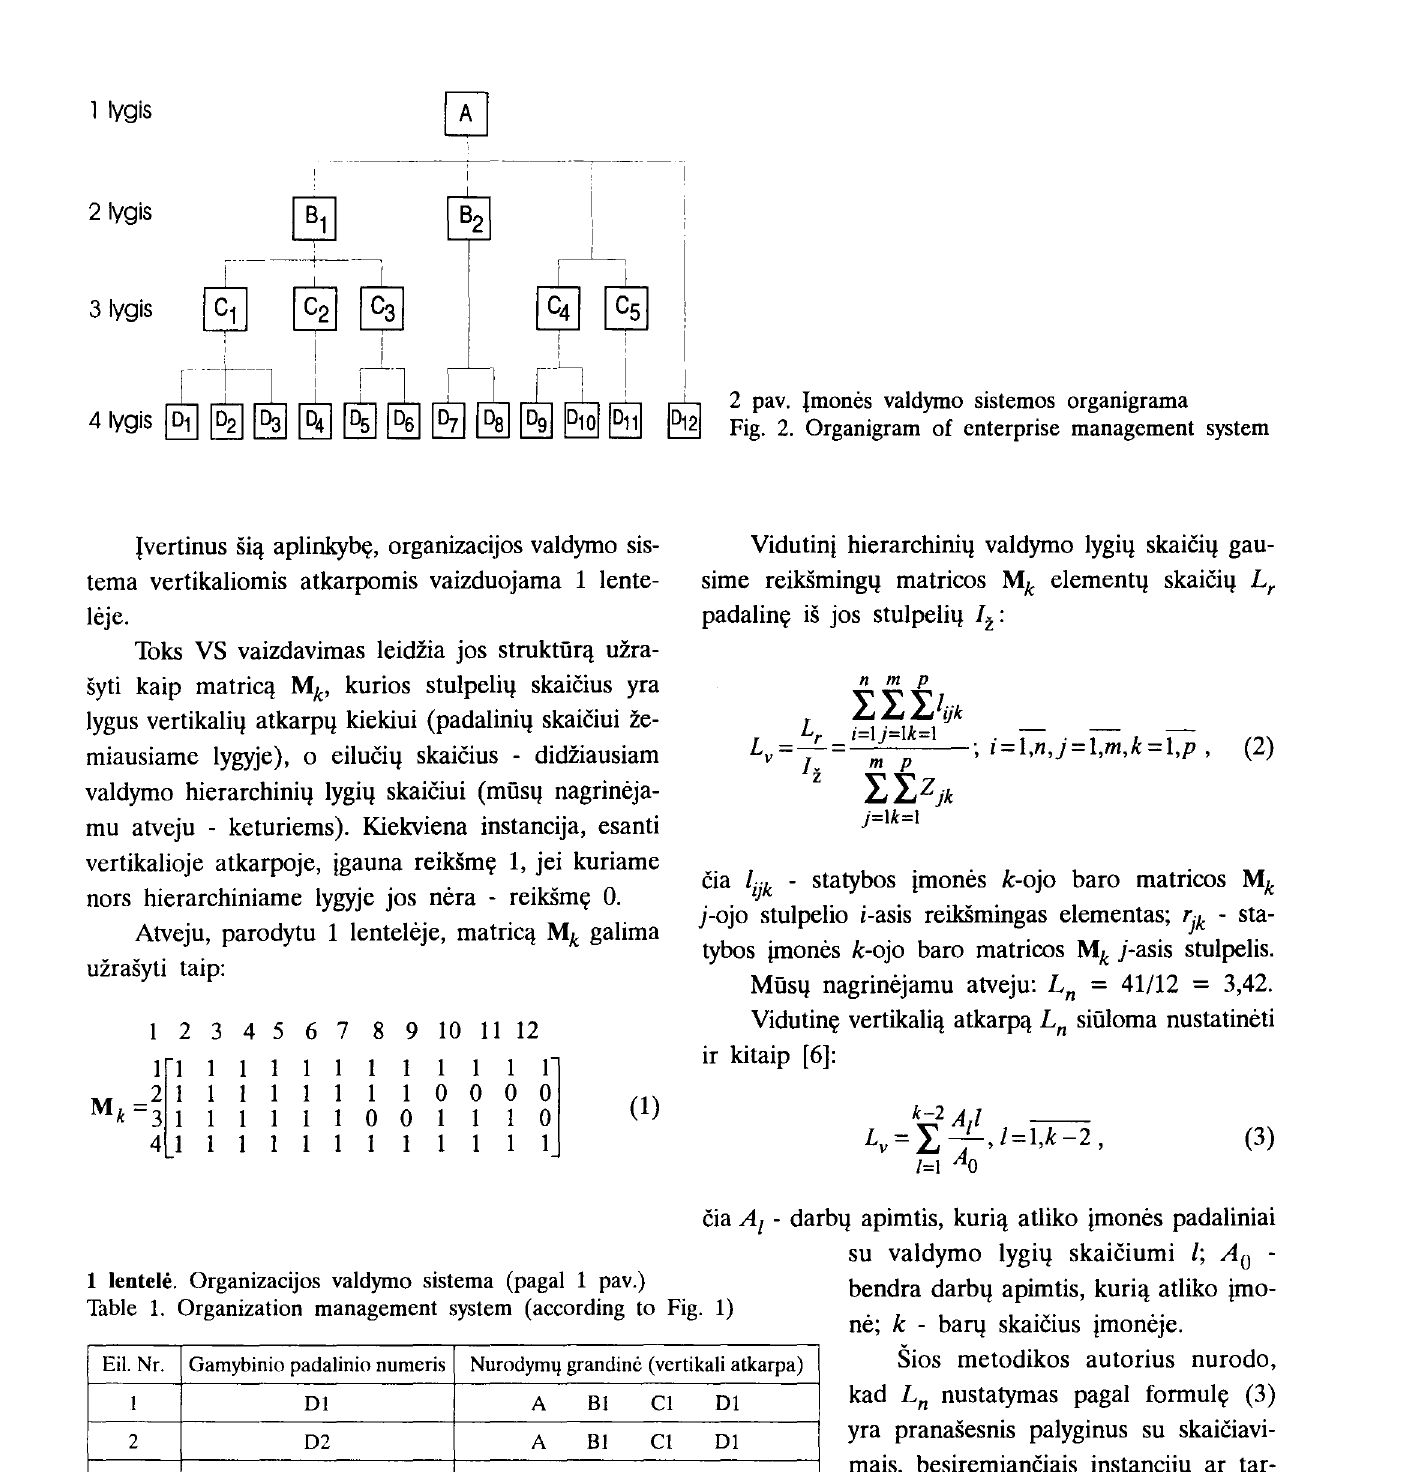
bendra darbq apimtis, kuri(l atliko imo ne; k - barq skaicius